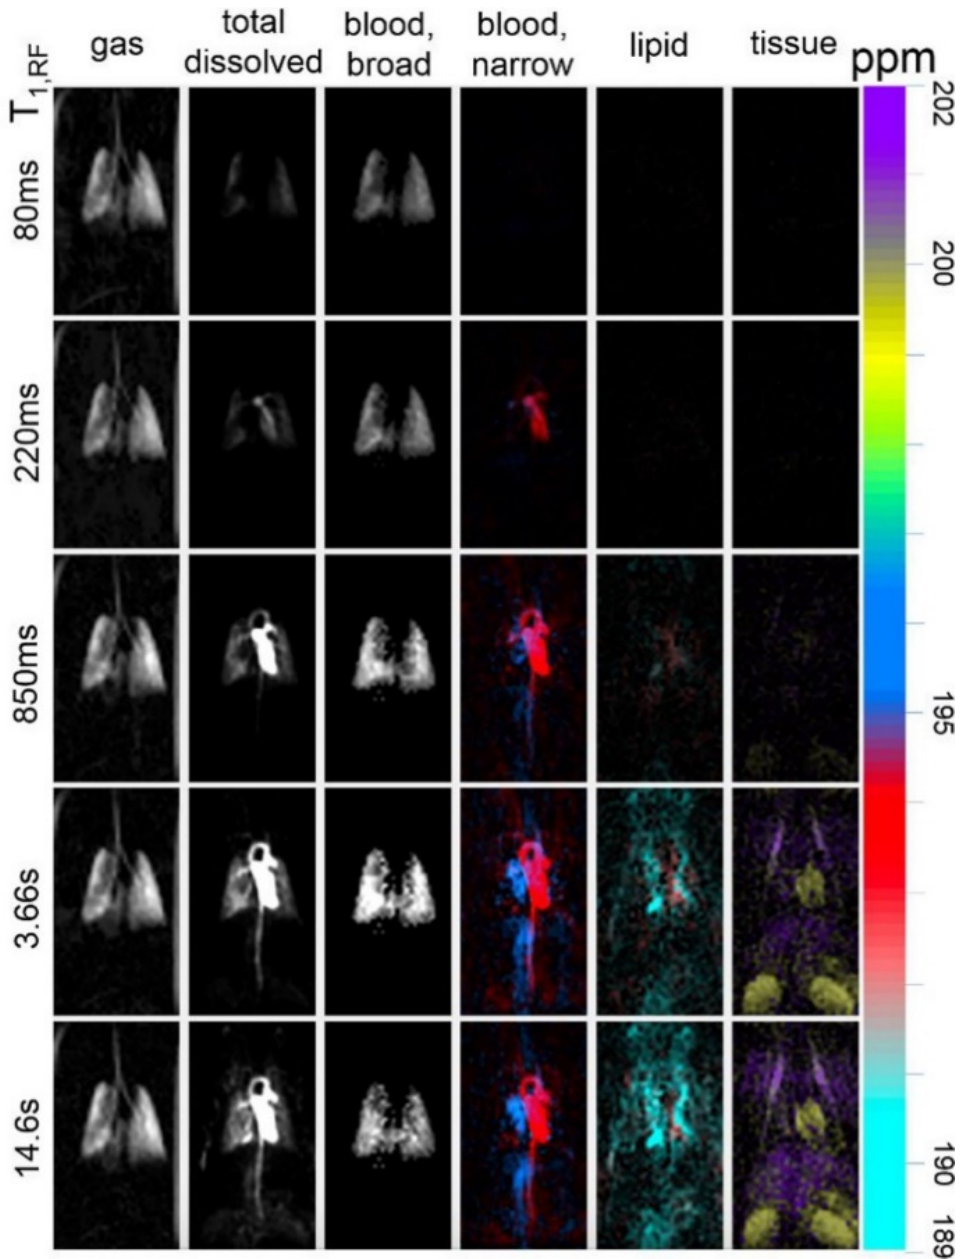
Figure 28. Distinct “compartmental” features along the circulatory system can be visualized by integrating under respective dissolved-phase linewidth peaks. T 1, RF times (left) correspond to how long HXe magnetization persists in the body and, consequently, how far within the body it travels. The large range in chemical shifts associated with dissolved-phase HXe entering distinct anatomical compartments is visualized in individual, color-coded maps. Reprinted with permission from Loza, et al. ( IEEE Trans Med Imaging 2019, ref. [57]).